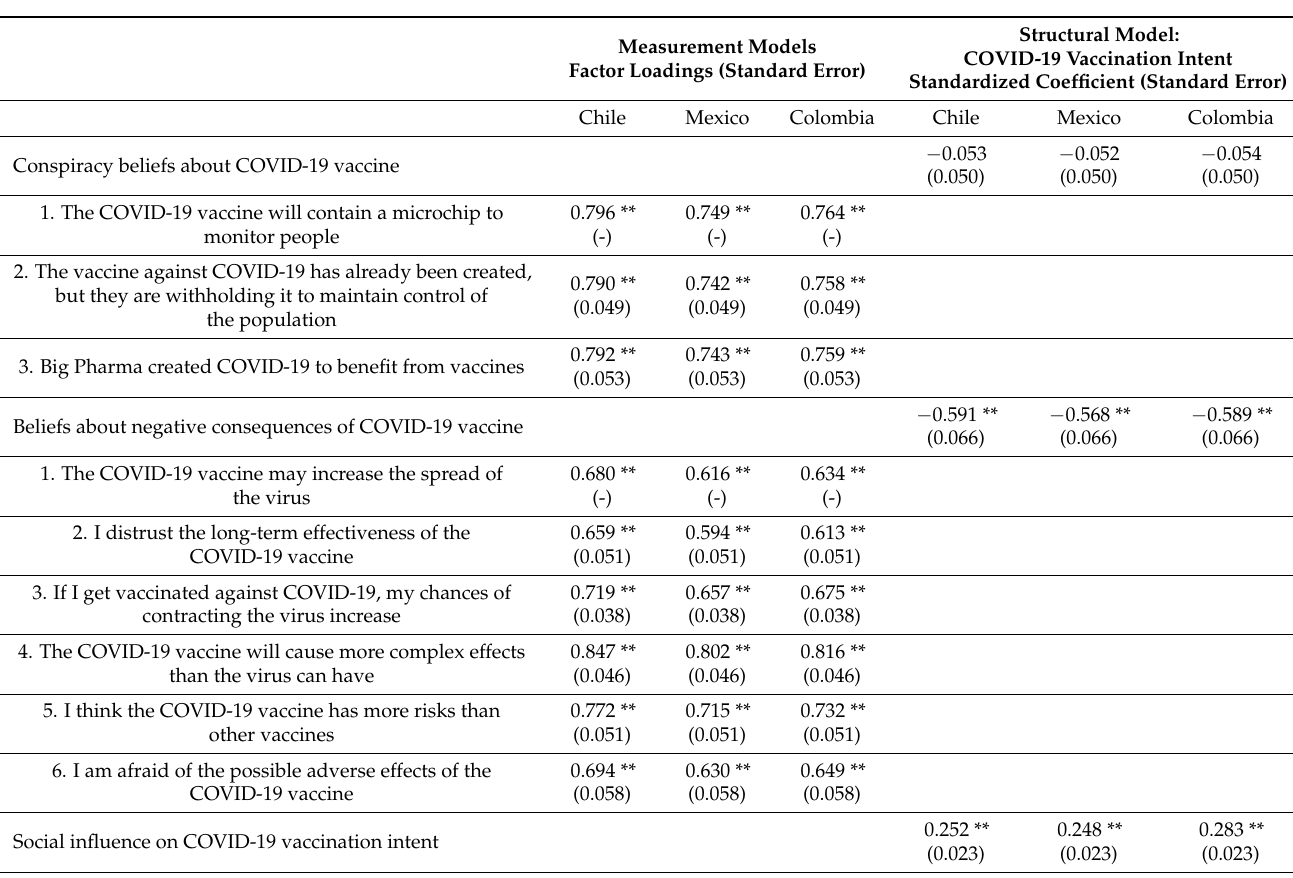
Figure 1. Model (invariant for the Chilean, Mexican, and Colombian sample) predicting COVID-19 vaccination intent. Dashed lines represent nonsignificant paths ( p > 0.05). Table 4. Factor loadings and regression coefficients of the model explaining COVID-19 vaccination intent.